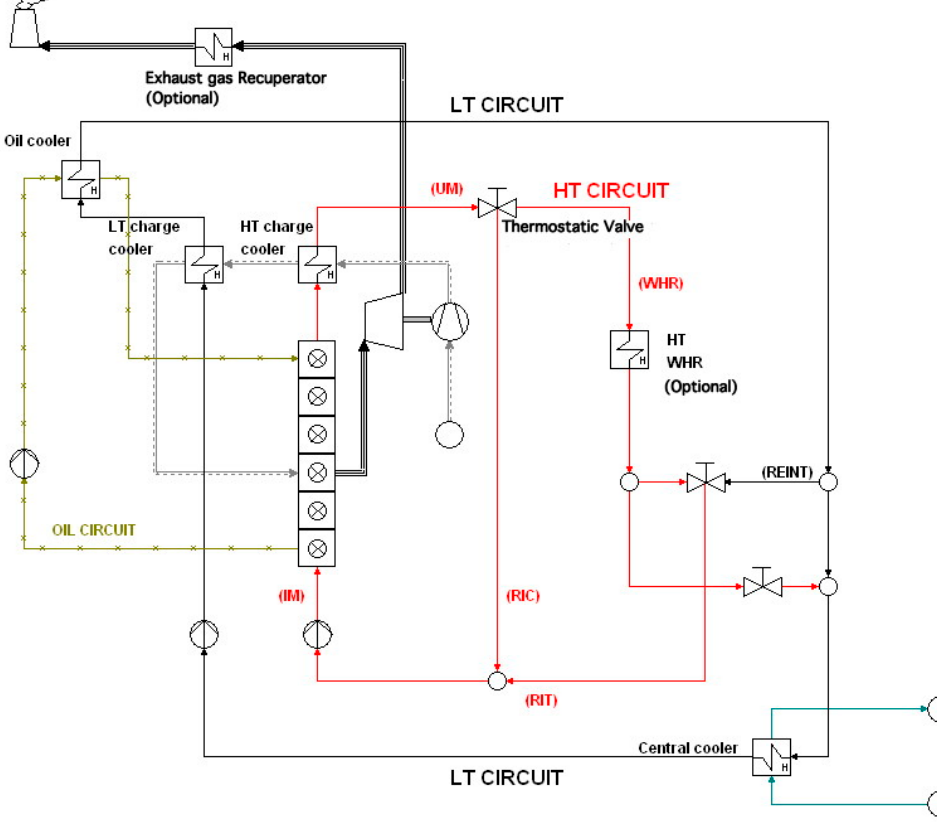
Figure 2. Simplified schematic of the cooling circuits and exhaust gas of the engine W6L50DF.